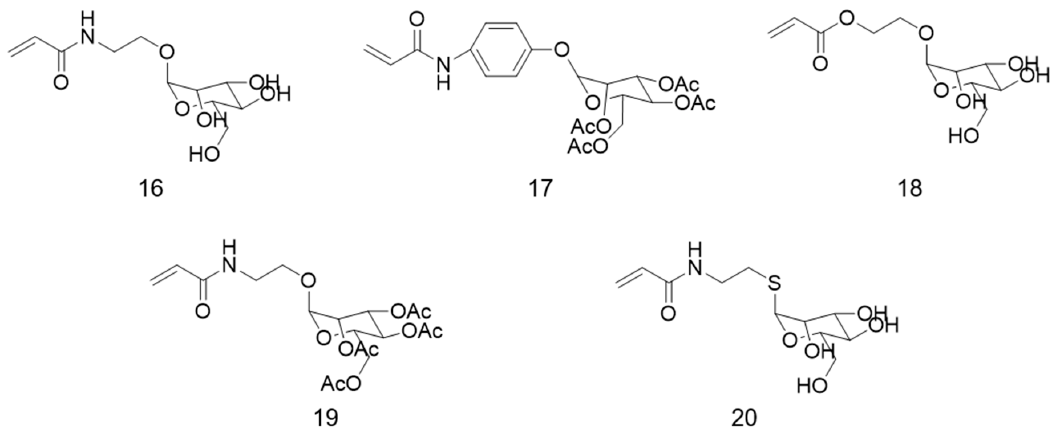
Figure 7. Structures of protected and non-protected mannose-based vinyl monomers used for the synthesis of polymer brushes by RDRP. 16: 2 ′ -acrylamidoethyl- α - ᴅ -mannopyranoside; 17: p- acrylamidophenyl 2,3,4,6-tretra- O -acetyl- α - ᴅ -mannopyroside; 18: 2-methacryloyloxyethyl ᴅ - mannopyroside; 19: 2 ′ -acrylamidoethyl 2,3,4,6-tetra- O -acetyl- α - ᴅ -mannopyranoside; 20 : 2 ′ - acrylamidoethyl-1-thio-(2)- ᴅ -mannopyranoside.